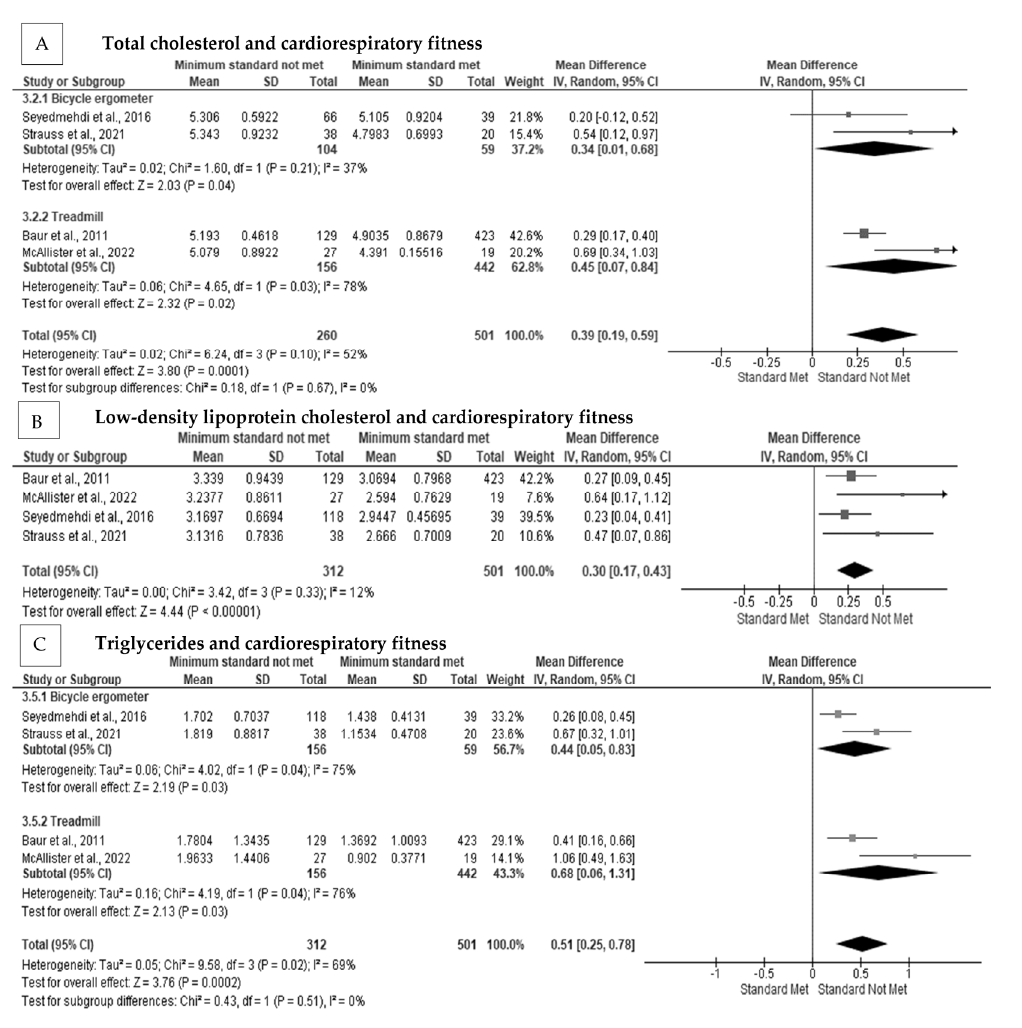
Figure 5. The association between cardiorespiratory fitness and blood lipid concentrations in firefighters: ( A ) The association between cardiorespiratory fitness and total cholesterol concentration with subgroup analysis [30,40,69,79]; ( B ) the association between cardiorespiratory fitness and low- density lipoprotein concentration with subgroup analysis [30,40,69,79]; ( C ) the association